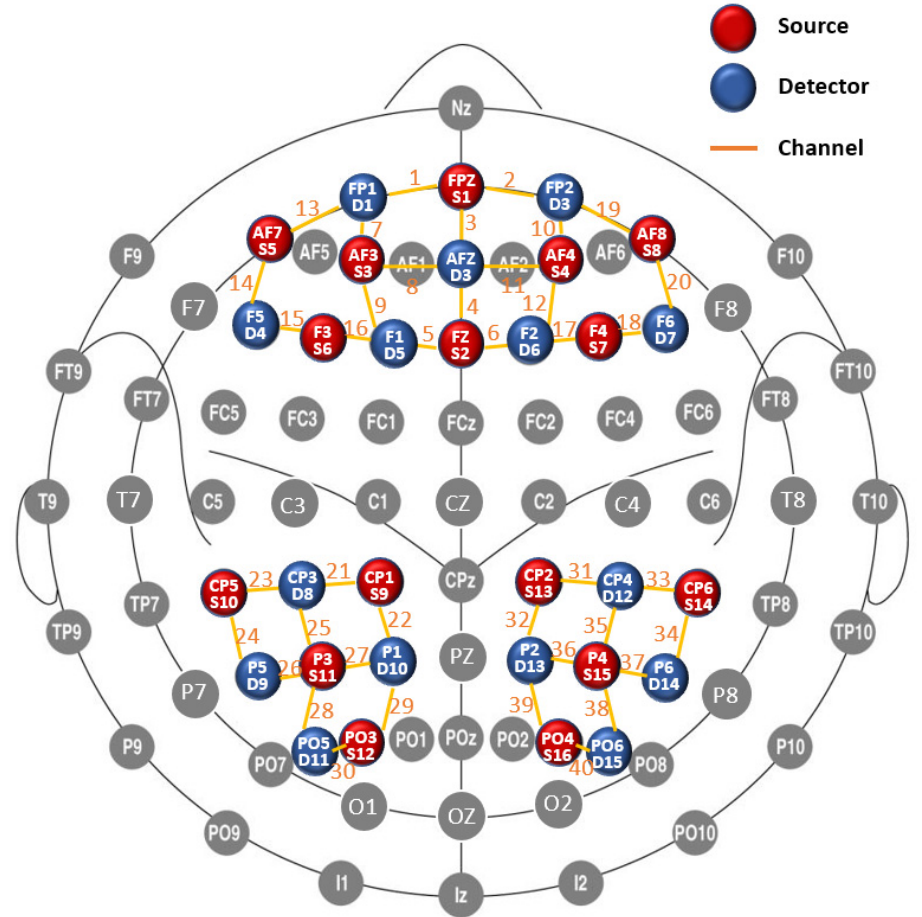
Figure 2. Location of sources, detectors and channels on the 2D Plane. Note 1. MNI coordinates. channel 01 ( − 13, 70, − 12), channel 02 (14, 71, − 12), channel 03 (0, 68, 8), channel 04 (1, 55, 40), channel 05 ( − 10, 44, 54), channel 06 (13, 44, 54), channel 07 ( − 27, 68, 0), channel 08 ( − 14, 70, 19), channel 09 ( − 23, 58, 35), channel 10 (28, 69, − 1), channel 11 (16, 71, 19), channel